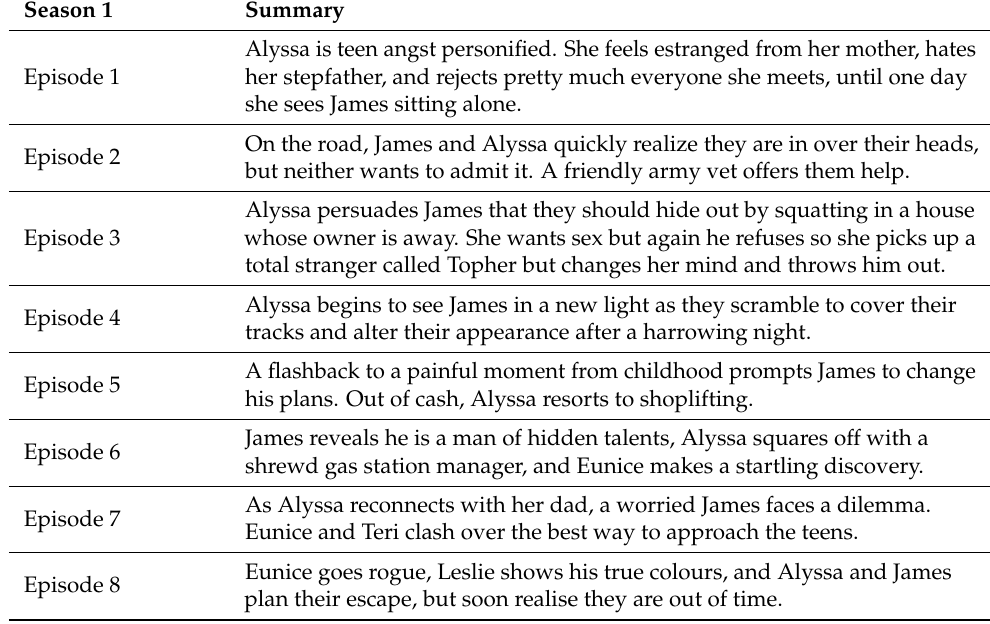
Table A1. Episode guide. Source: IMDb (2022).